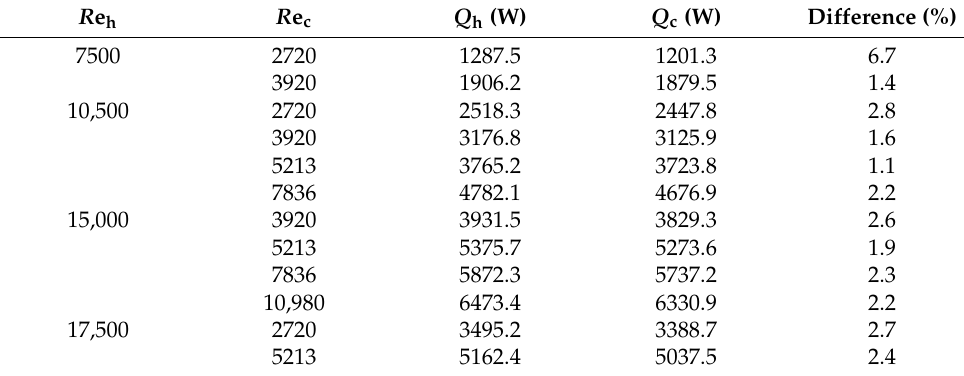
Table 4. Comparison of heat exchange rate of hydraulic oil and water in heat exchanger.